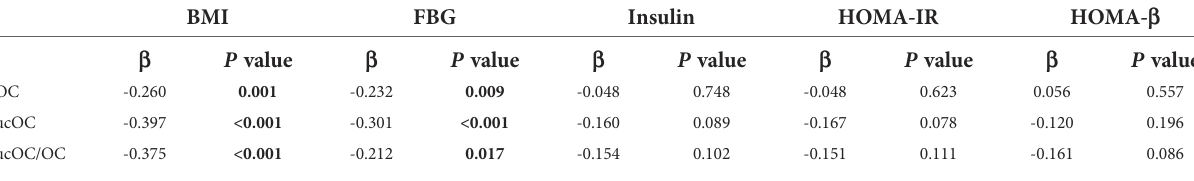
TABLE 3 Multiple linear regression analysis to assess correlation between serum OC and ucOC levels with glycolipid metabolic